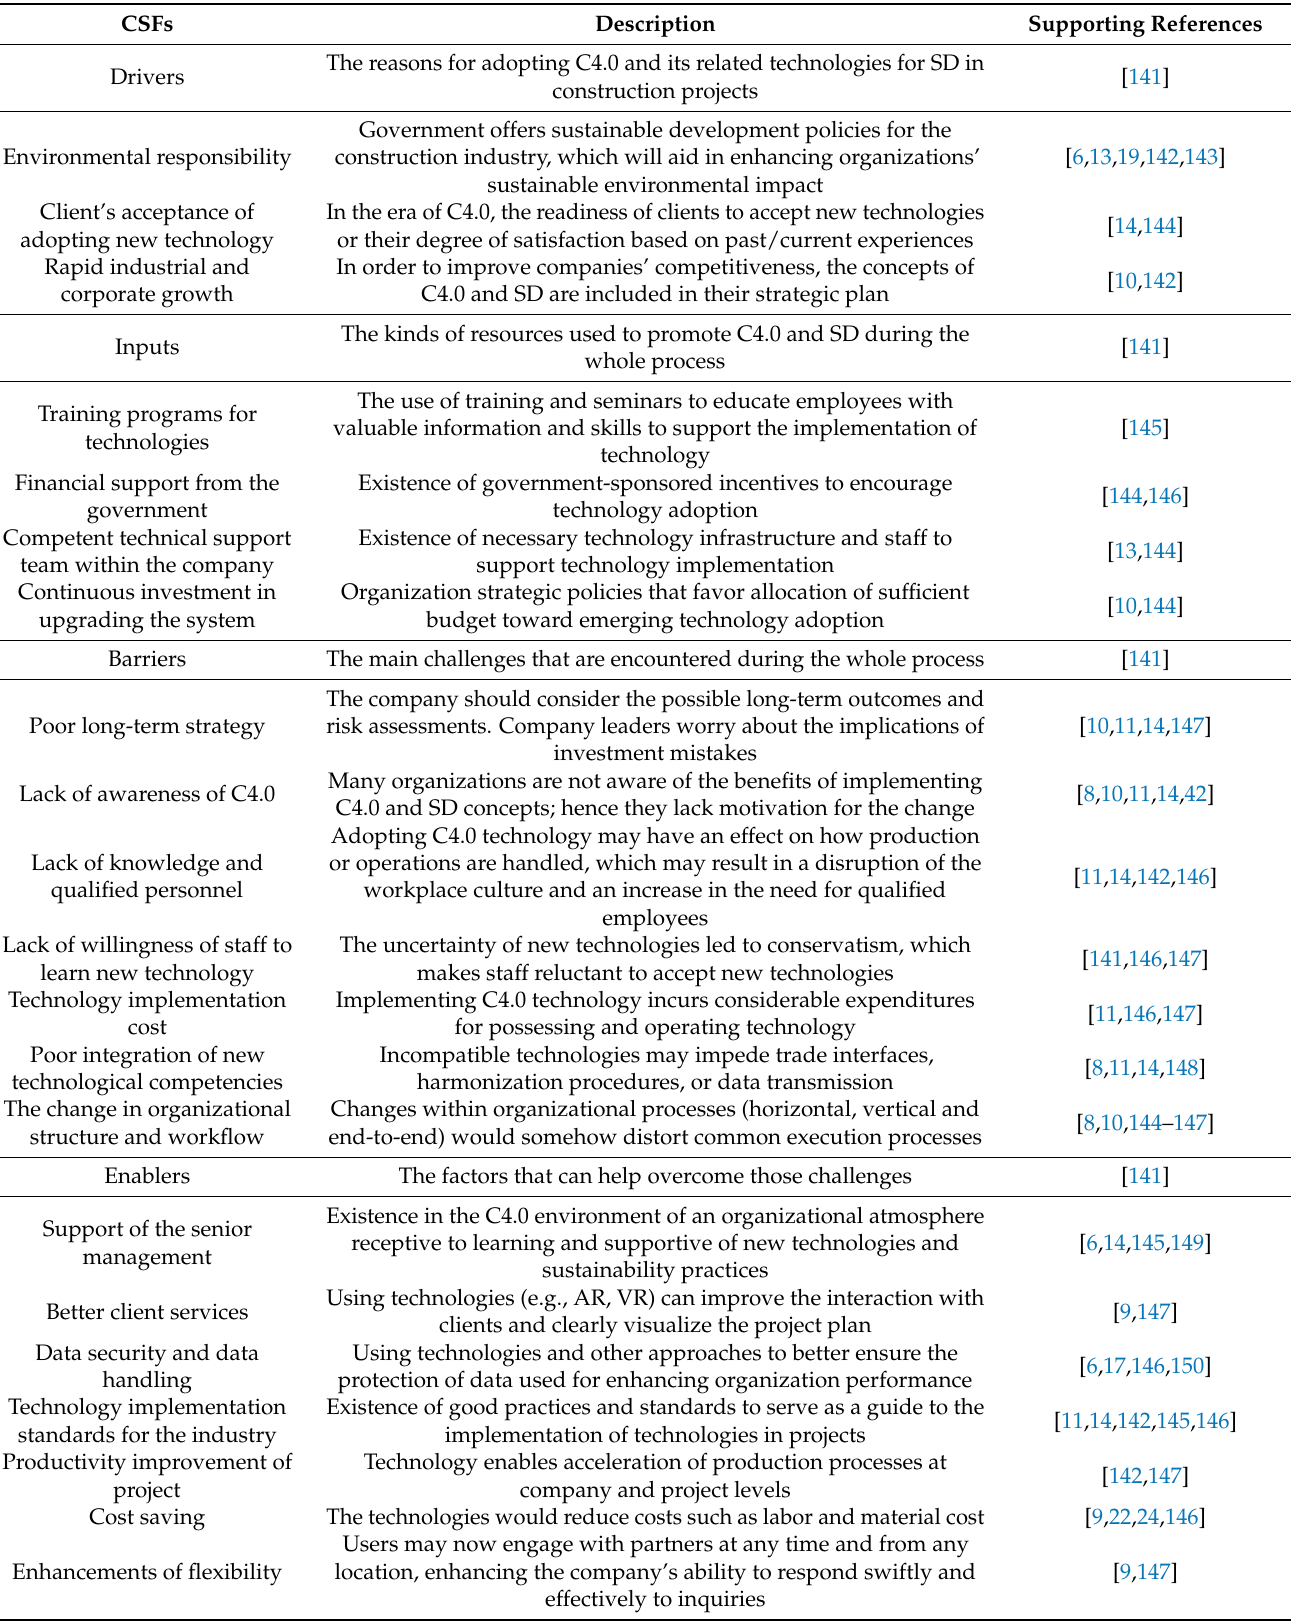
Table 12. Critical success factors of using C4.0 for